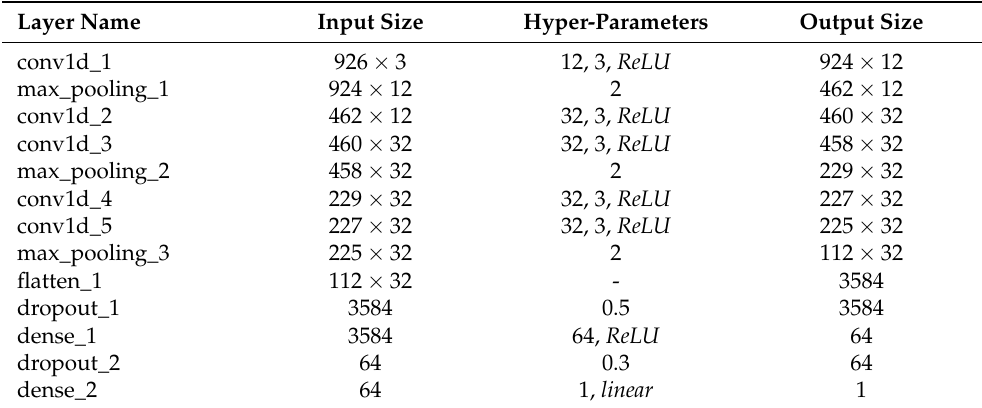
Figure 1. Schematic of machine learning model for internal resistance (IR) prediction. Table 1. Proposed architecture of convolutional neural network (CNN) model for prediction of IR. Hyper-parameters are given in the format: filters, kernel size, activation for conv1d layers; pool size for max_pooling; dropout rate for dropout; nodes, activation for dense